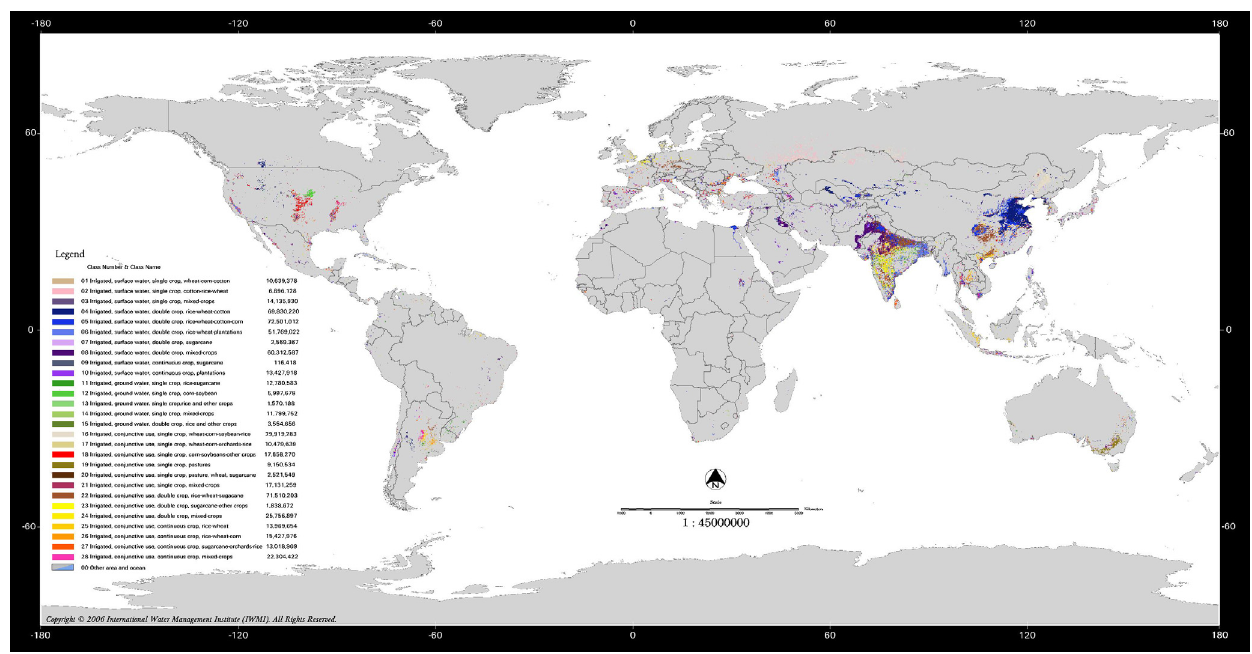
Figure 1. Full pixel irrigated areas (FPIAs) for the 28-class Global irrigated area map